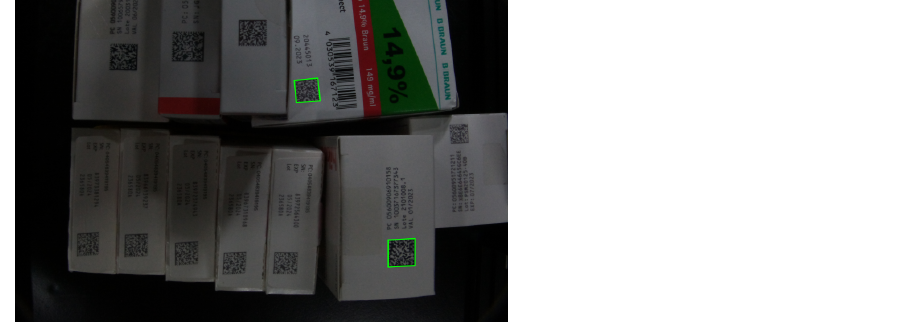
Figure 12. Acquired image with a natural illuminance of 150 Lux and LED panels off. An extraction ratio of 18% was observed.